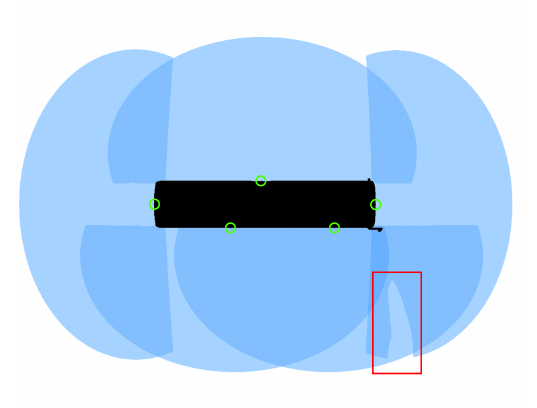
Figure 2. Positioning (green) and field of view (blue) of the five top-view cameras on the bus (facing right) - the right front mirror causes the cut-out in the red